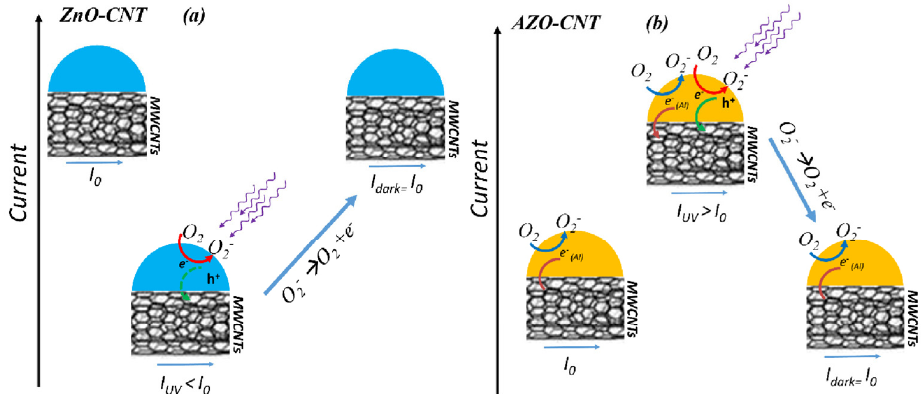
Figure 7. Scheme of involved mechanisms in the dark or under irradiation conditions for both ZnO– CNT ( a ) and AZO–CNT ( b ) composites. In this scheme, we are considering a voltage applied to the composite layer generating a current I 0 through the MWCNTs. I UV is the current under irradiation, while I dark is the current in dark conditions (I dark = I 0 ) .